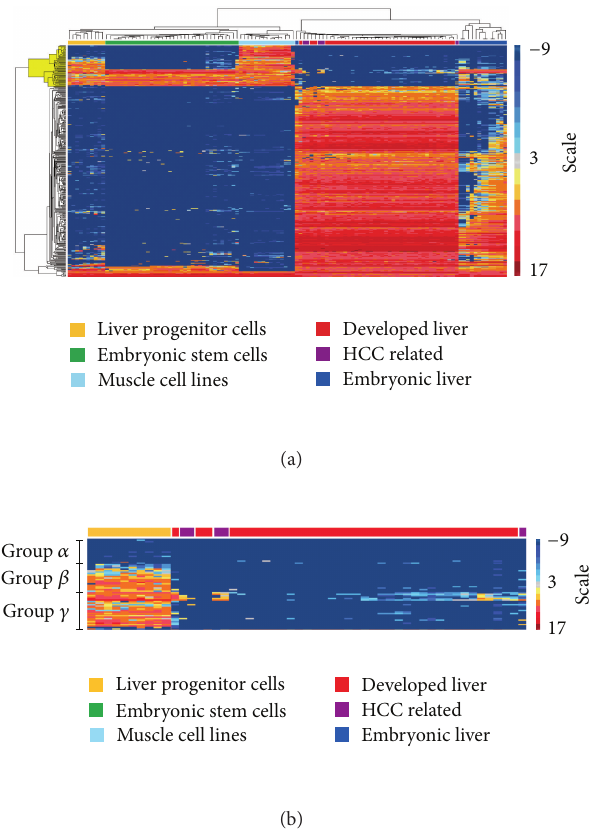
Figure 4: Distinct expression profiles for liver progenitor cells identify three gene expression groups. (a) Hierarchical clustering of expression profiles that correlate with known liver progenitor cell markers.(b)Closeviewoftheyellowhighlightedrowsfrom(a),with particular focus on the LPC and developed liver groupings. Three distinct groups of gene expression patterns ( 𝛼 , 𝛽 , and 𝛾 ) are